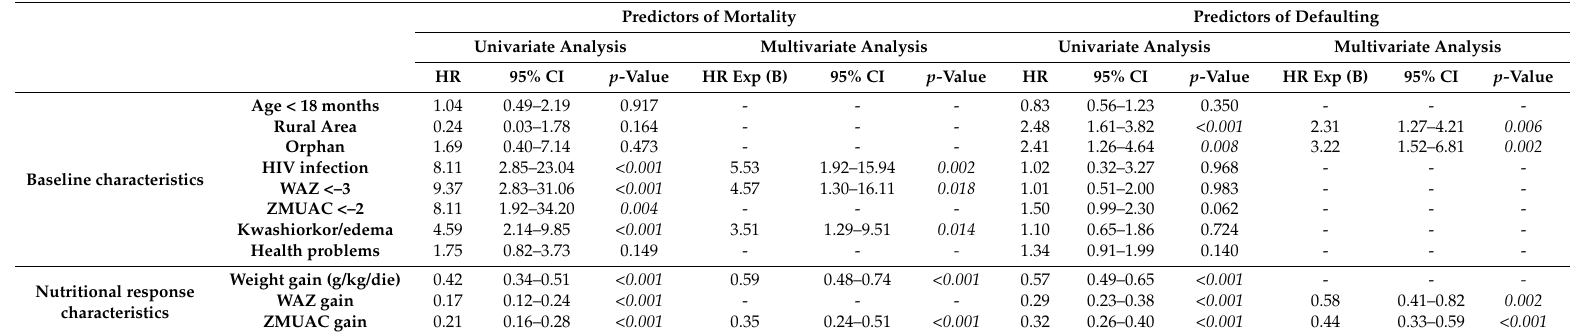
Table 3. The predictors of mortality and defaulting. Cox proportion risk